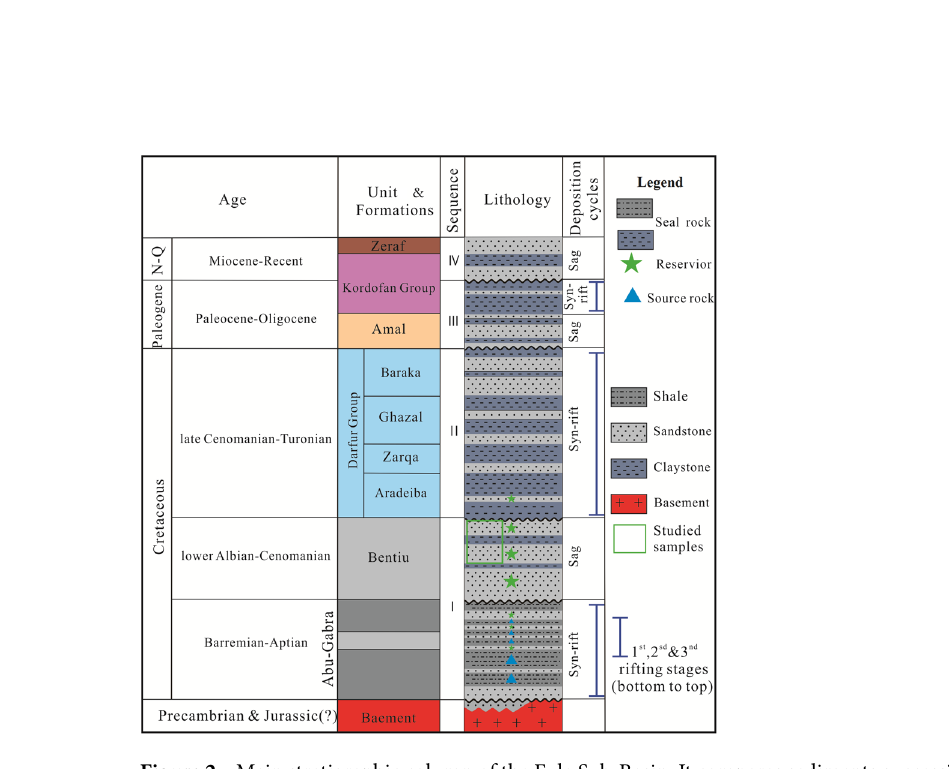
Figure 2. Main stratigraphic column of the Fula Sub-Basin. It compares sediments succession from Late Jurassic/Early Cretaceous–Quaternary with 4 succession (I-IV) separated by unconformities (created from information in reference 1,2 using CorelDRAW Graphics Suite 2018 v20.0.0.633 https:// www. corel. com/